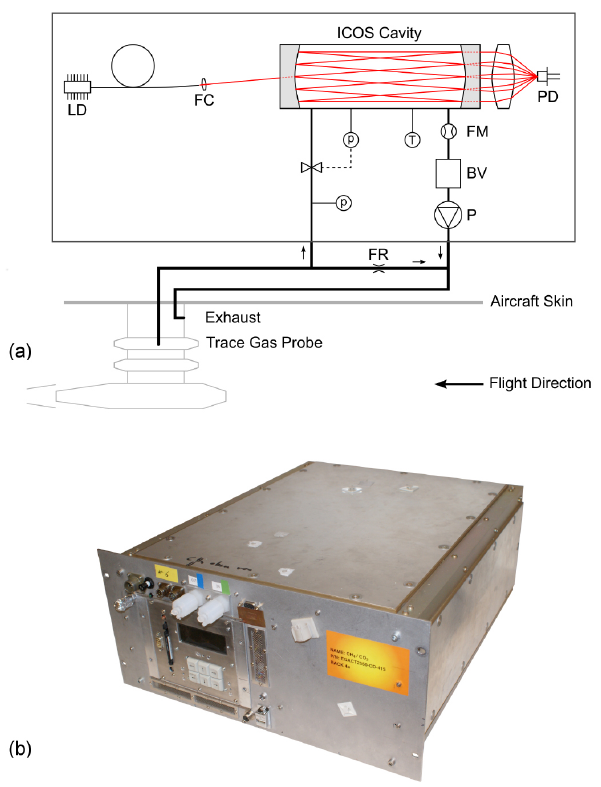
Fig. 1. (a) Schematic setup of the airborne FGGA deployed aboard CARIBIC (additional laser for CO 2 measurements not shown). LD: laser diode, FC: fiber collimator, PD: photo detector, PV: propor- tional valve, p: pressure sensor, T: temperature sensor, FM: flow meter, BV: buffer volume, P: pump, FR: flow restrictor. (b) Photo- graph of the modified